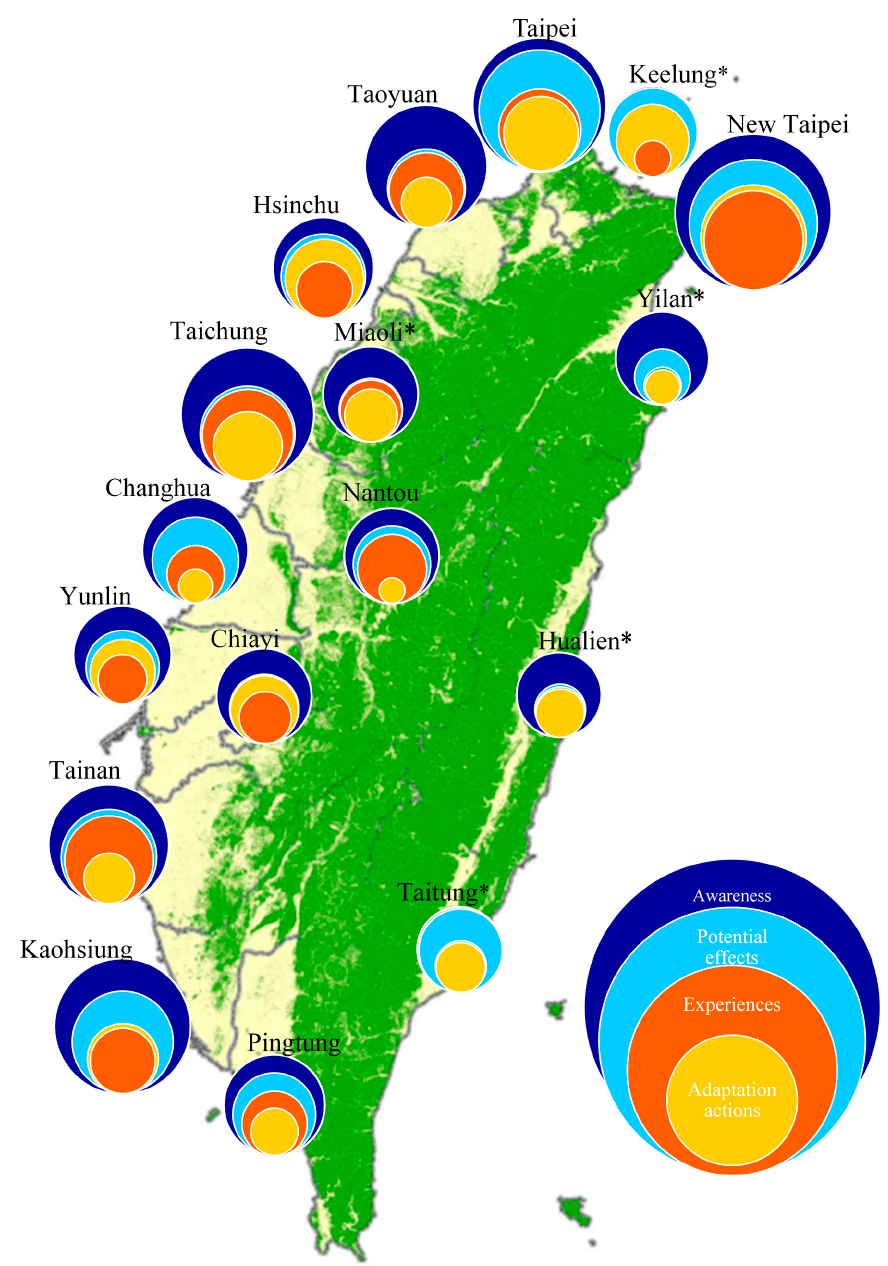
Figure 4. Venn diagram. Note 1: A Venn diagram is a diagram used to represent sets or classes (in a slightly loose sense) in the mathematical field of set theory (or theory of classes). This diagram is used to demonstrate the mathematical or logical connections between collections of objects or sets. This diagram is particularly suitable for presenting approximate relationships between sets or classes, or for being used to conduct derivation (or understanding the derivation of) the rules of set or class operations. Note 2: The size of the Venn diagram is positively related to the sample size of each county or city; the area of the circle is positively related to the number of samples. Note 3: * means the Venn diagram was finely adjusted for clarity and is not a true representation of the percentage of